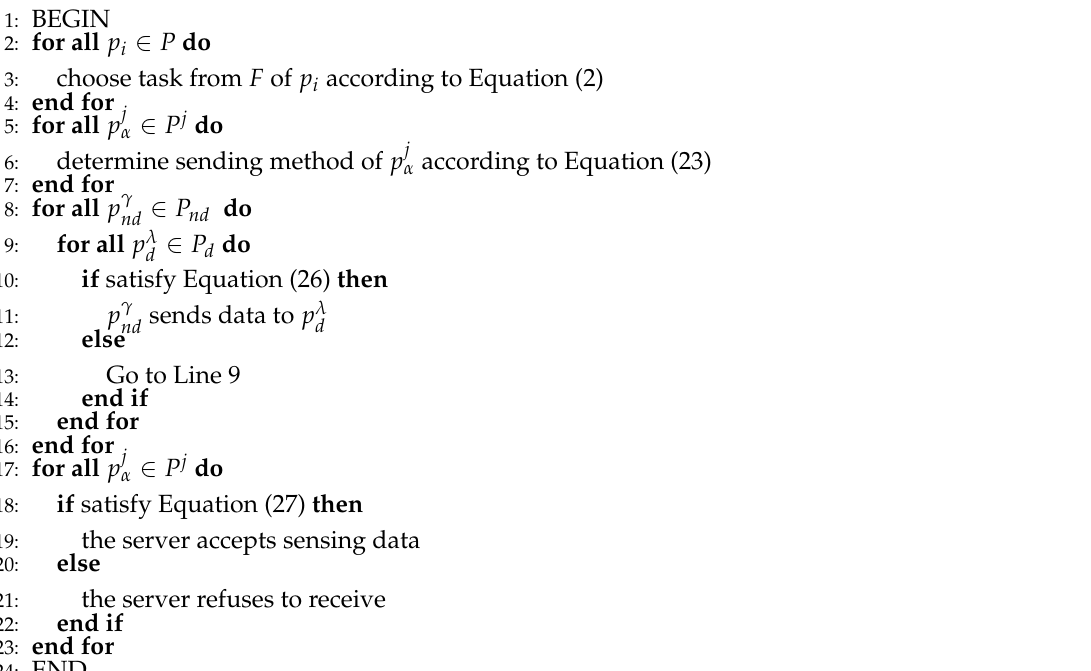
Algorithm 1 PSAA data collecting